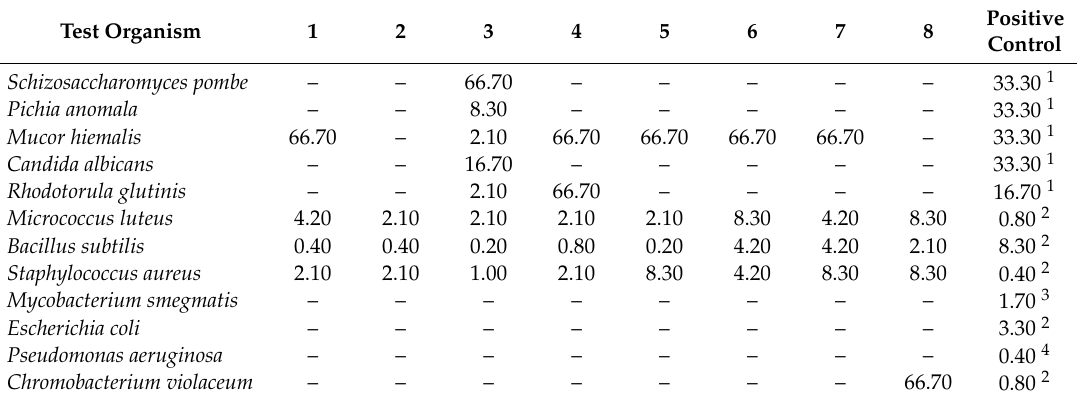
Table 3. Minimum inhibitory concentration (MIC, µ g / mL) of 1 – 8 against bacterial and fungal test